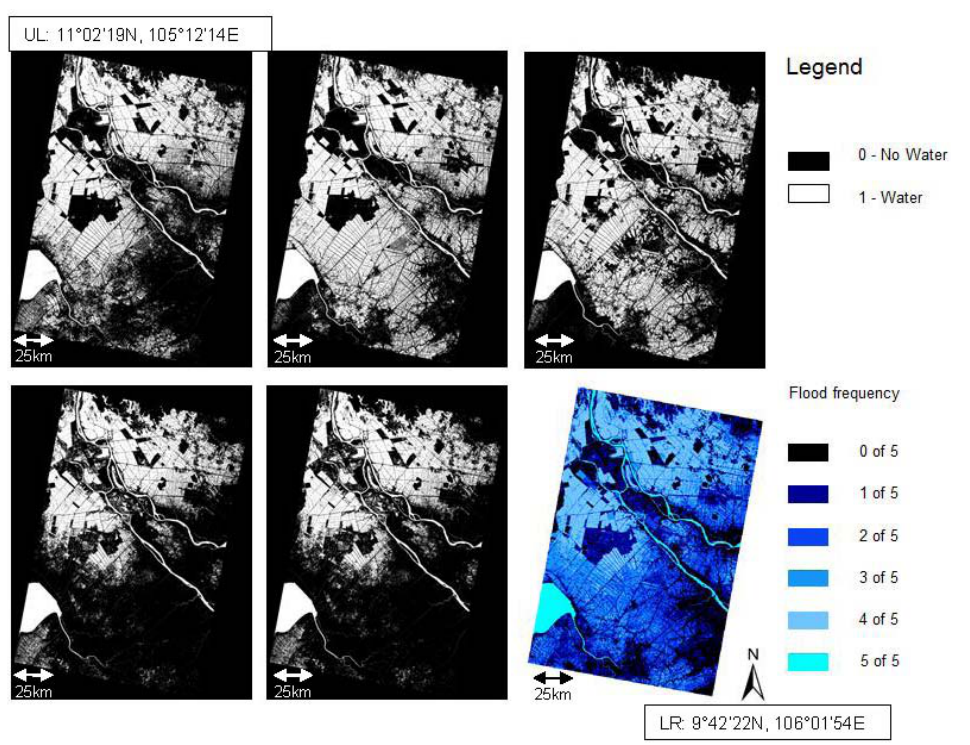
Figure 4. Water masks derived from TerraSAR-X ScanSAR images of 18 June, 23 August, 25September, 28 October, and 30 November (from left to right ), and a stack product depicting flood frequency over the rainy season observation period from the middle of June to the end of November. Can Tho province is located in the Center of the image. The ocean bay located in the Southwest (white) is Rach Gia Bay of the Gulf of Thailand. Upper